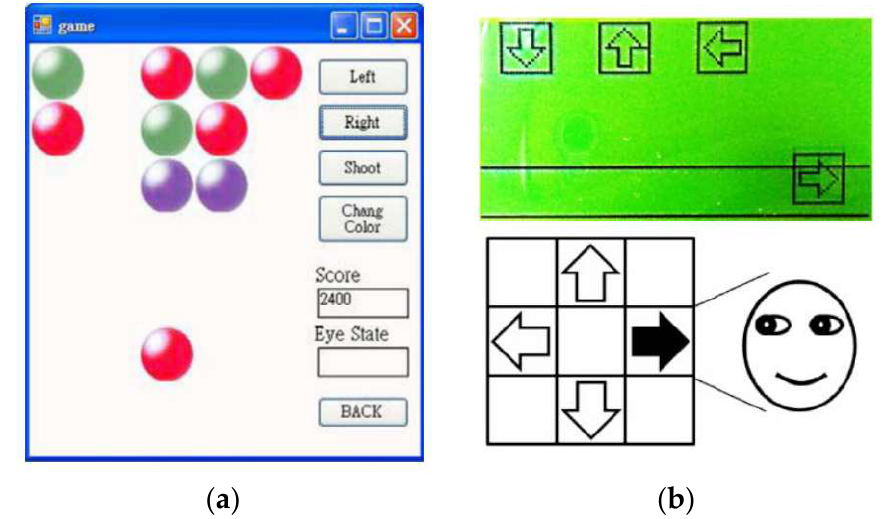
Figure 8. Games controlled using eye movement. ( a ) Shooting game to find the same color [53]. ( b ) Dance Dance Revolution game in which the user moved his/her eyes to follow directional instructions [38]. Reprinted with permission.